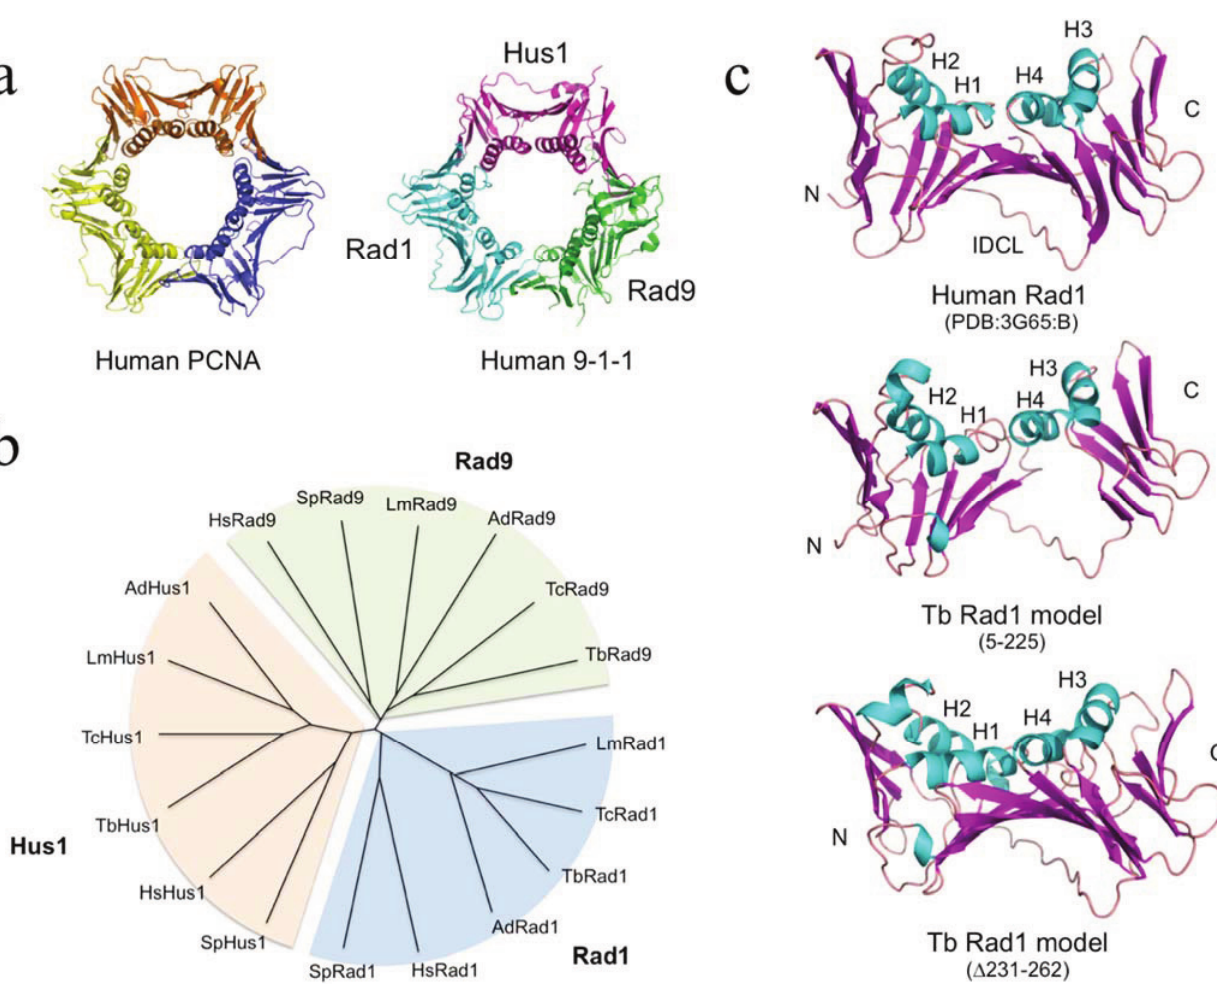
Figure 1. The kinetoplastid 9-1-1 complex. ( a ) Human sliding clamp structures: proliferating cell nuclear antigen (PCNA) (PDB:1VYM) and 9-1-1 (PDB:3G65). Individual subunits of the 9-1-1 are labelled; ( b ) Phylogenetic analysis of human, fission yeast and kinetoplastid 9-1-1 complex proteins. Abbreviations: Hs, Homo sapiens ; Sp, Schizosaccharomyces pombe ; Tb, Trypanosoma brucei ; Tc, T. cruzi ; Lm, Leishmania major ; Ad, Angomonas deanei . UniProtKB accession numbers are given in Supplementary Table S1; ( c ) Structural model for residues 5–225 of the putative T. brucei Rad1 protein generated by Phyre 2 [10,11] alongside the human Rad1 structure (chain B from PDB:3G65). Abbreviations: H1-H4, (cid:4)-helices 1–4; IDCL, interdomain connector loop. Protein structures were visualised using